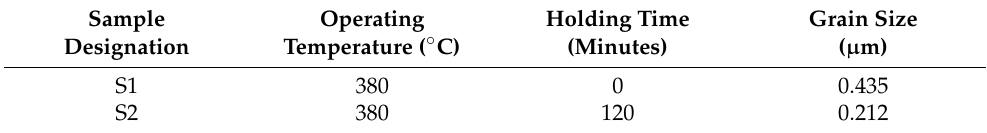
Table 5. Grain size for minimum and maximum hot-press forging